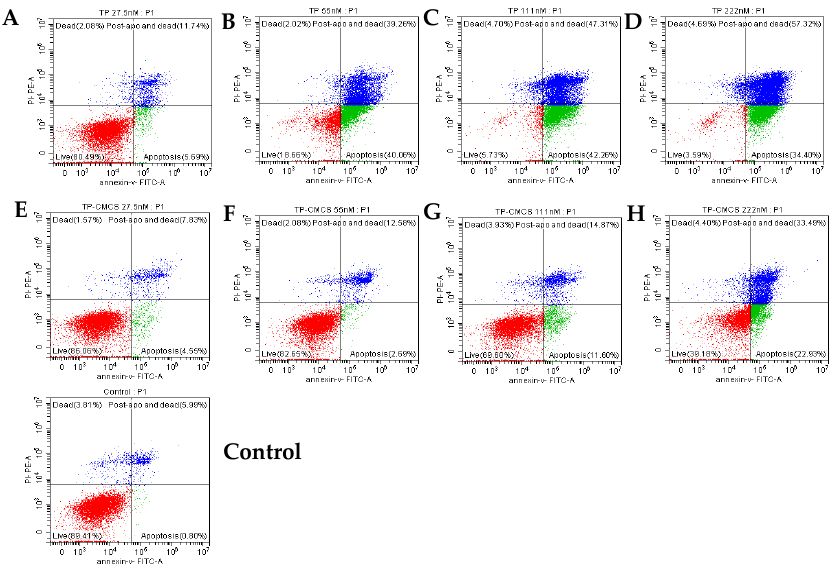
Figure 3. The RAW264.7 cell apoptosis induced by TP and TP-CMCS detected using flow cytometric method. The effect of TP ( A , B , C , D ) or TP-CMCS ( E , F , G , H ) equal to TP concentration 27.5, 55, 111, 222 nmol/L and control ( E ) 0 nmol/L.